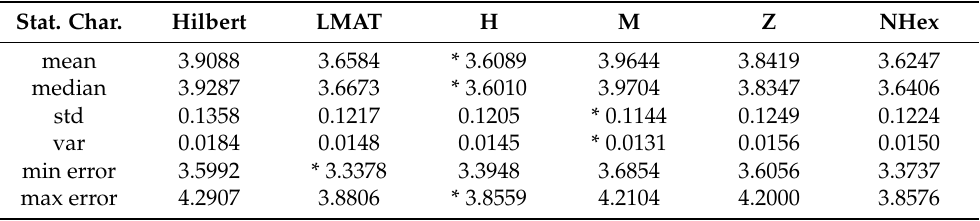
Figure 11. Localization errors of all mobile path planning models in ( a ) WCL, and ( b ) APT. Table 2. Statistical characterization of all mobile path planning models in terms of localization error for WCL.